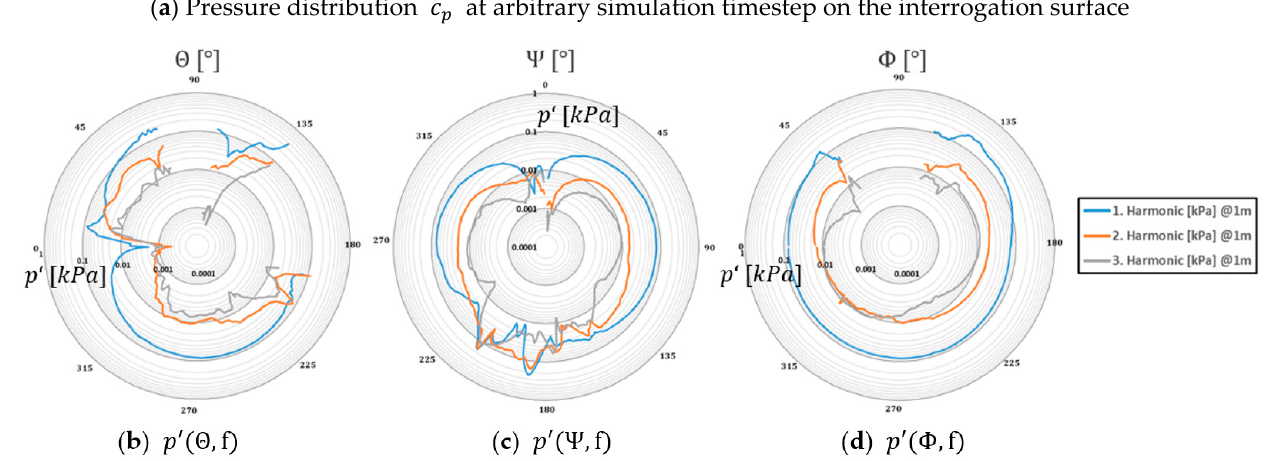
Figure 26. Directivity of harmonic frequencies on a passive sphere around the propeller.